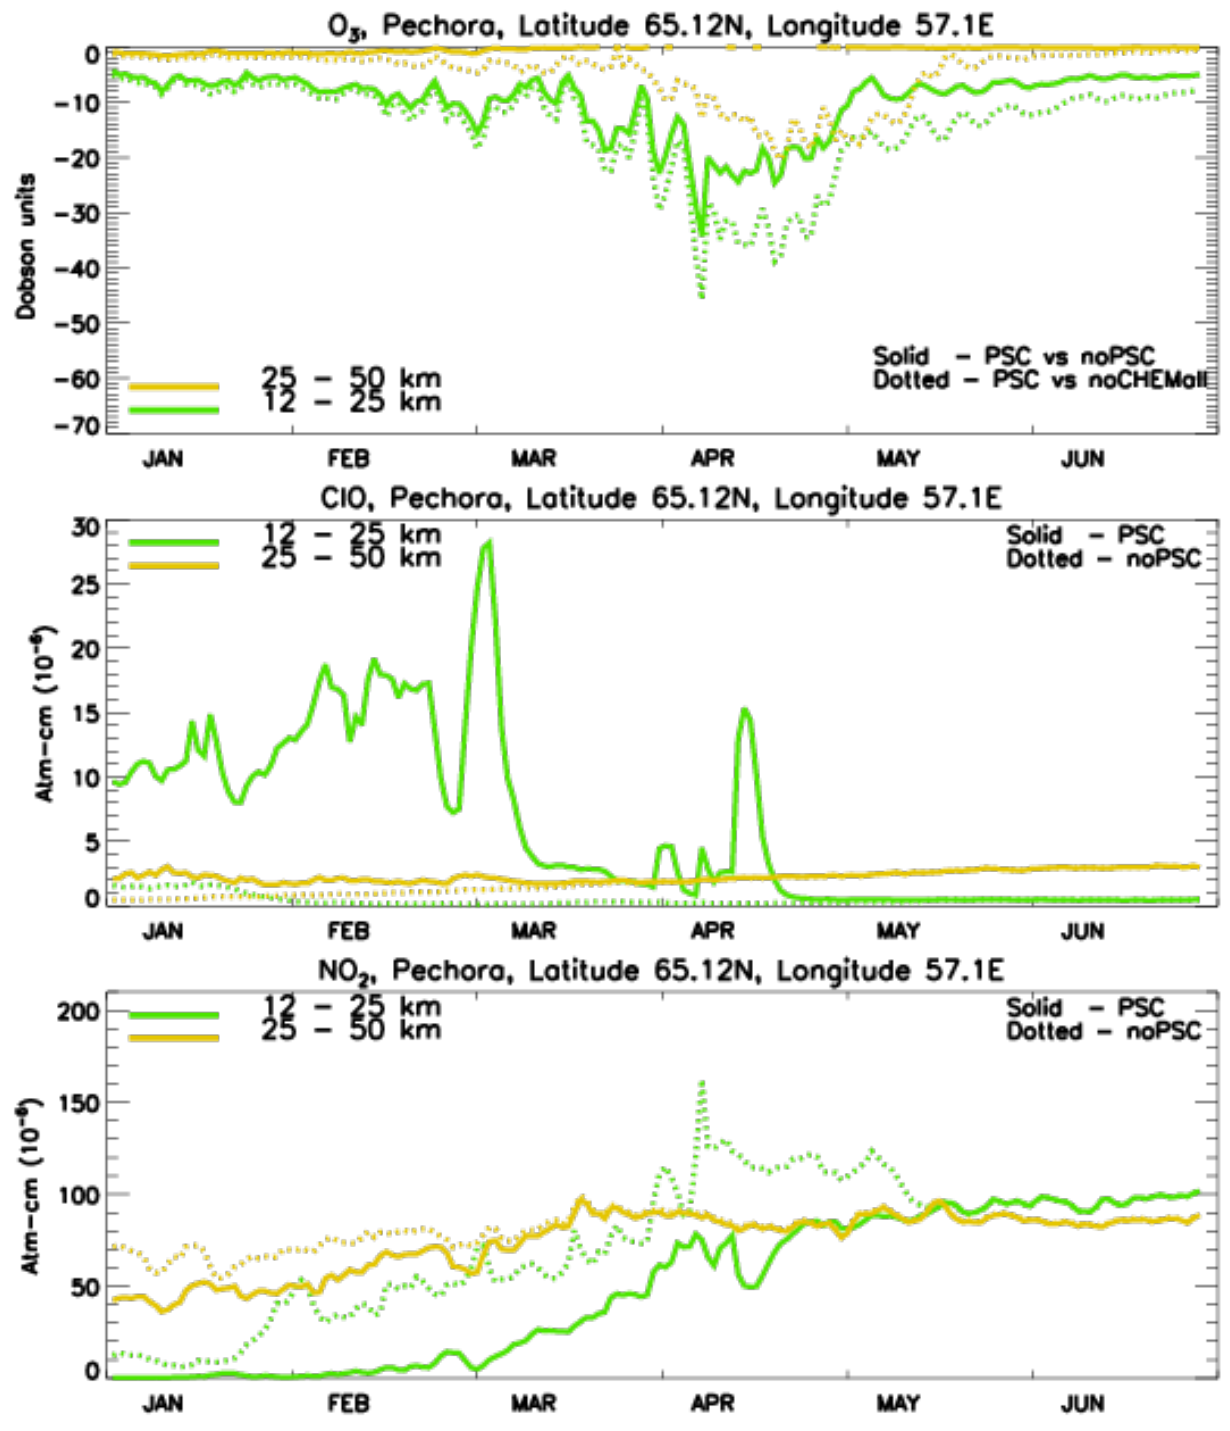
Figure 15. Pechora station values estimated with the CTM for the lower stratosphere (green) and the upper stratosphere (yellow): ( top ), the difference in ozone content for the scenarios PSC and noPSC (solid) and PSC, and PSC and noCHEM (dotted), chlorine monoxide ( middle ), and nitrogen dioxide ( bottom ) for the PSC (solid) and noPSC (dots).